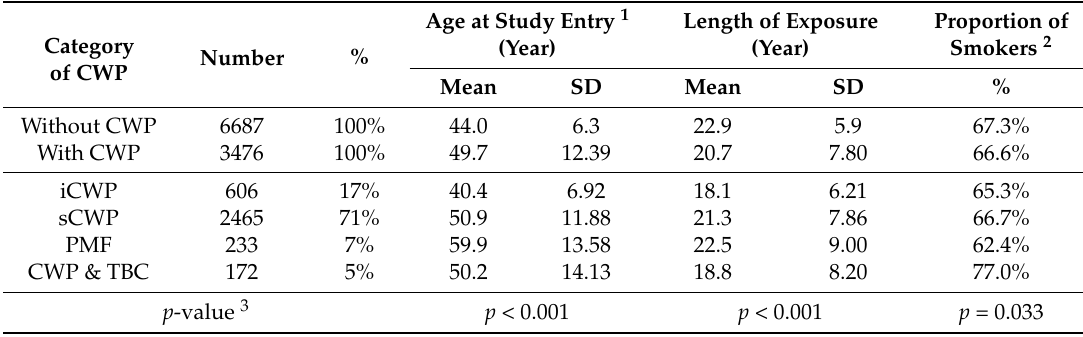
Table 1. Description of the cohorts of coal miners without and with coal-workers´ pneumoconiosis (CWP) and according to the severity of CWP.